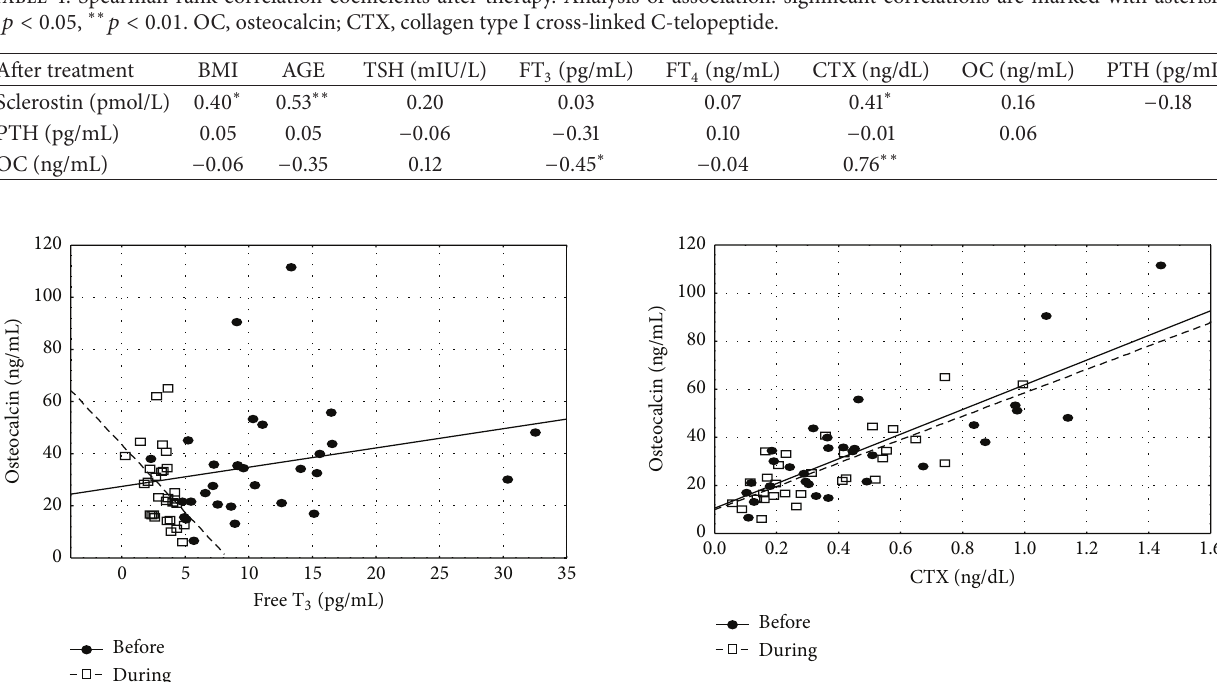
Figure 2: Scatterplot for osteocalcin and free T 3 , before and during hyperthyroidism treatment. Before treatment 𝑟 𝑠 = 0.42 , after treatment 𝑟 𝑠 = −0.45 , 𝑝 < 0.05 .